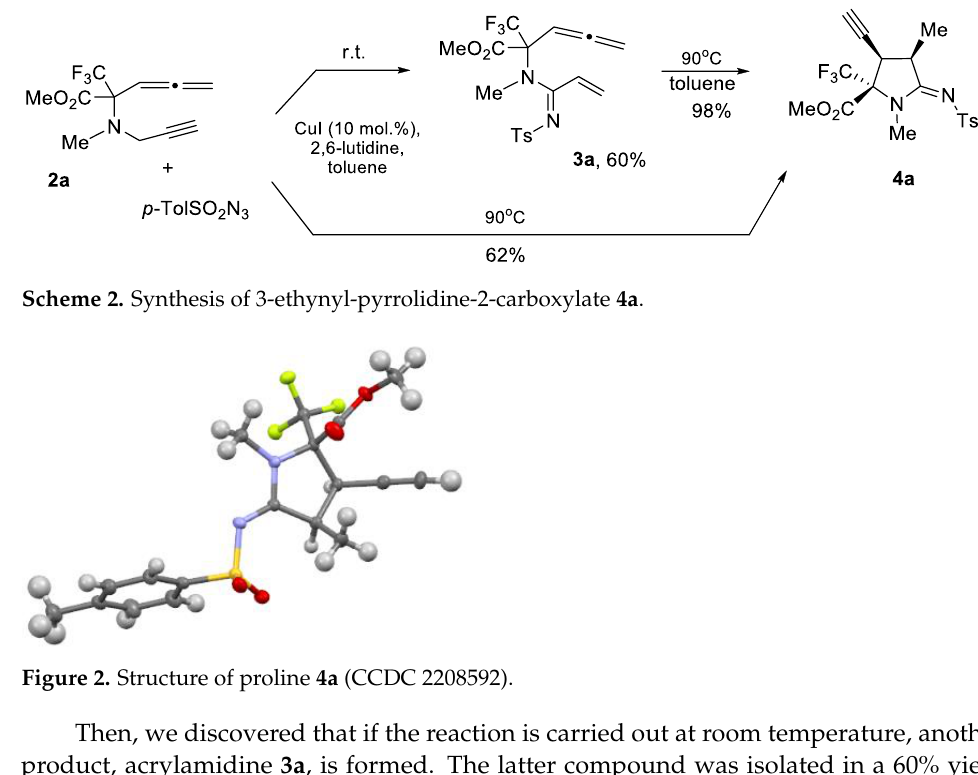
Figure 2. Structure of proline 4a (CCDC 2208592).